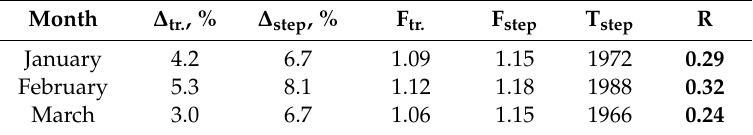
Table 11. The results of the e ffi ciency assessment of non-stationary models for the NAO time series in January, February and March (1951–2016 period with the size of the time series n = 66). The bold font for R denotes statistically significant correlation coe ffi cients of linear trends for the whole period. Month ∆ tr. , % ∆ step , % F tr. F step T step R January 4.2 6.7 1.09 1.15 1972